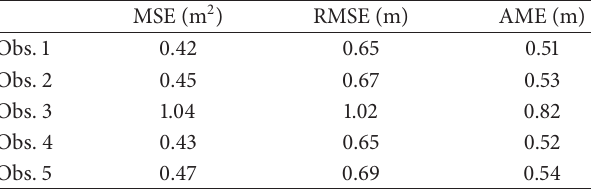
Table 6: Rule table for the operation in conjunctive use operation using FIS within low usage of subsurface